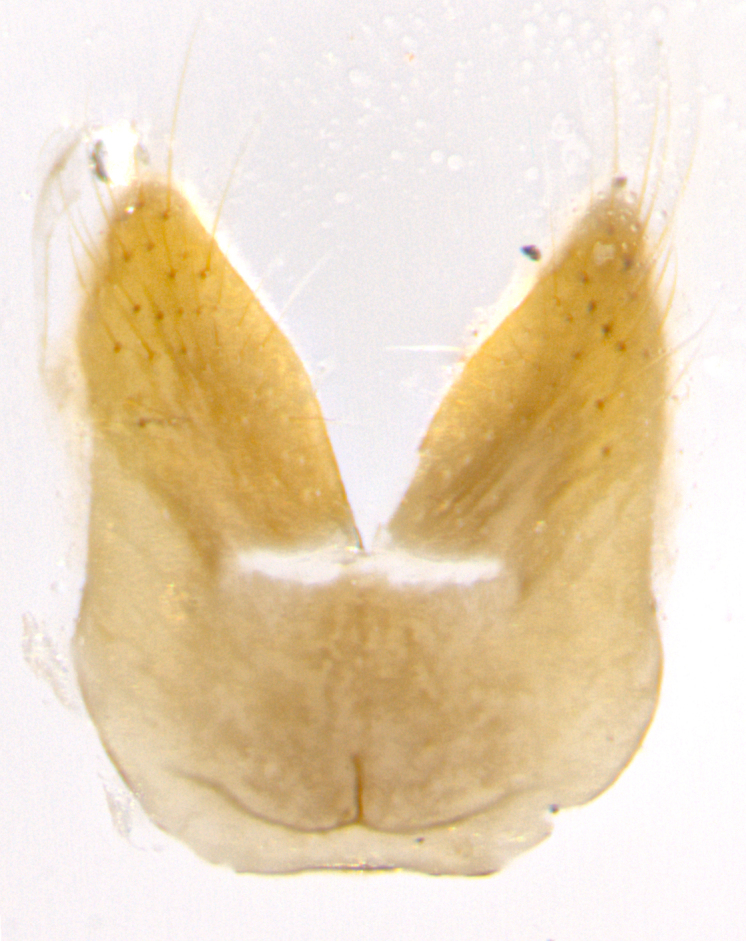
sternite 5, ventral view.